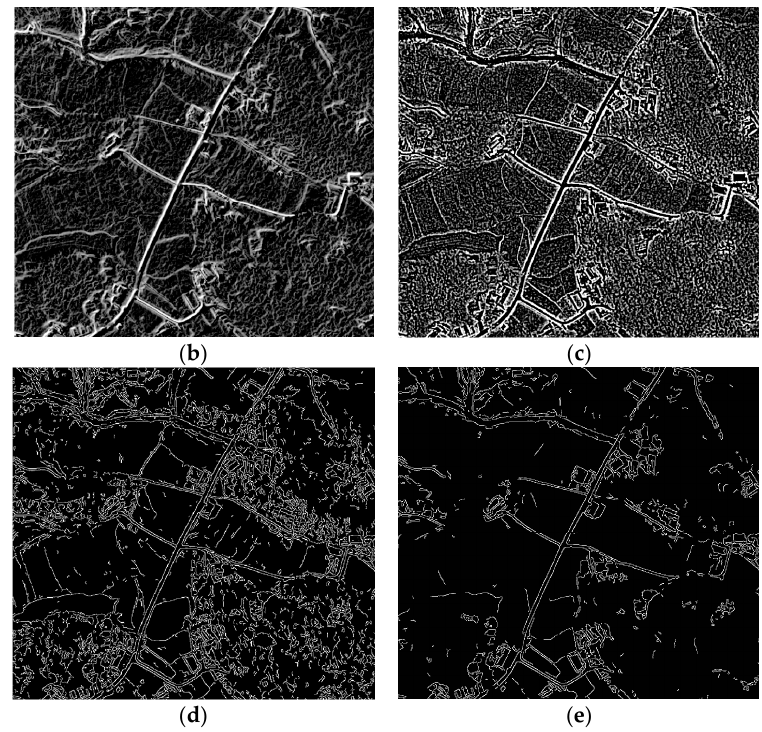
Figure 14. Comparison of edge detection operators: ( a ) original image, ( b ) Sobel operator, ( c ) LOG operator, ( d ) Canny operator, ( e ) edge detection with embedded confidence.